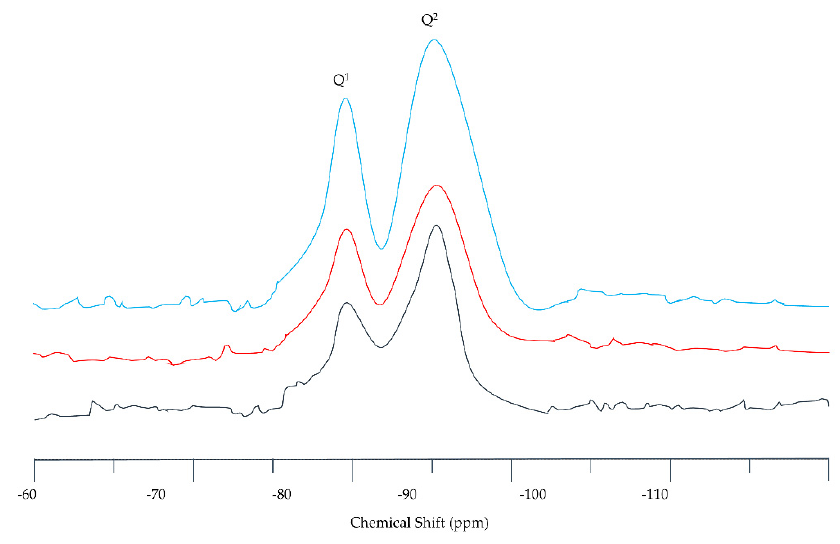
Figure 2. 29 Si MAS-NMR spectrum of C-S-H.